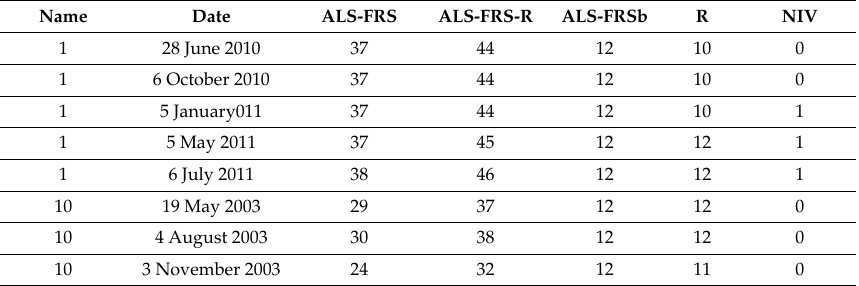
Table 7. ALSFRS output table, generated using ASLFRS (dynamic) and demographics (static) file information.